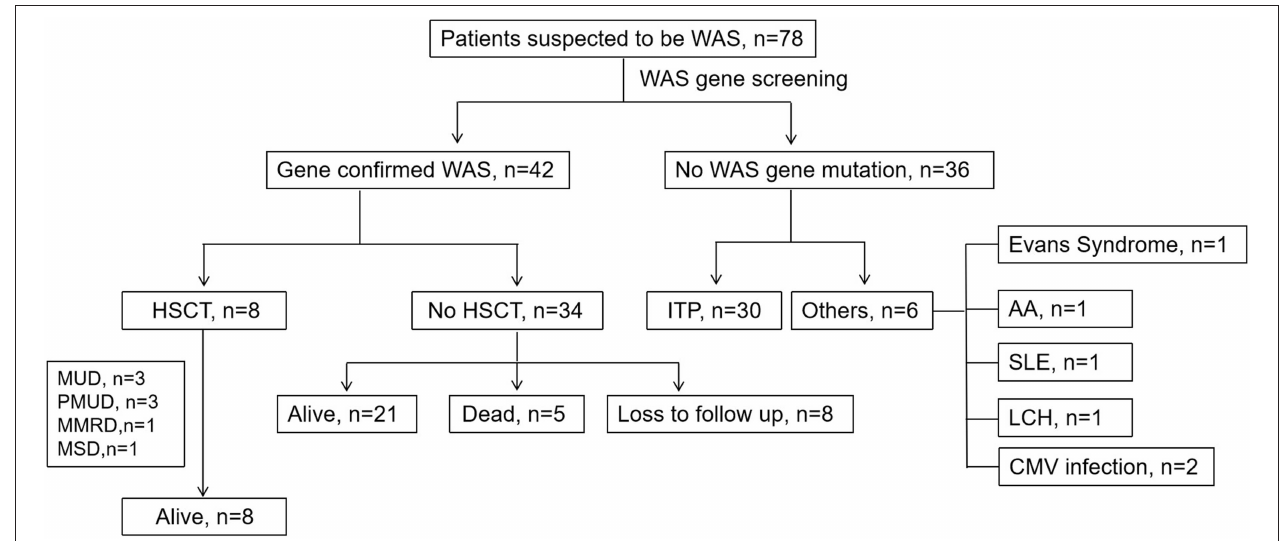
FIGURE 3 | The clinical course of patients suspected to have WAS. MUD, matched unrelated donor; PMUD, partially matched unrelated donor; MSD, matched-sib donor; MMRD, mismatched related donor; ITP, idiopathic thrombocytopenic purpura; SLE, systemic lupus erythematosus; LCH, Langerhans cell histiocytosis; HSCT, hematopoietic stem cell